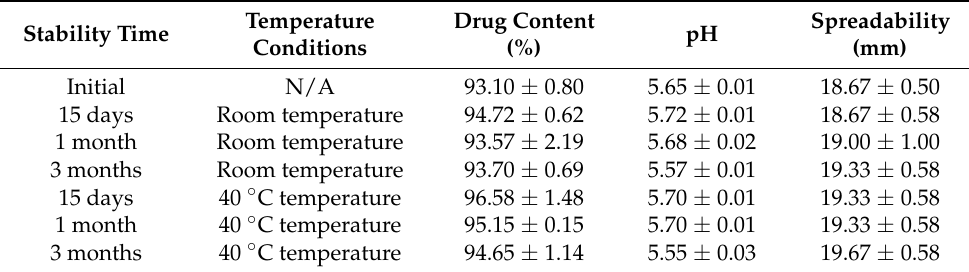
Table 12. Observed results for drug content, pH, spreadability for samples stored at room temperature and 40 ◦ C temperature ( n = 3, mean ±